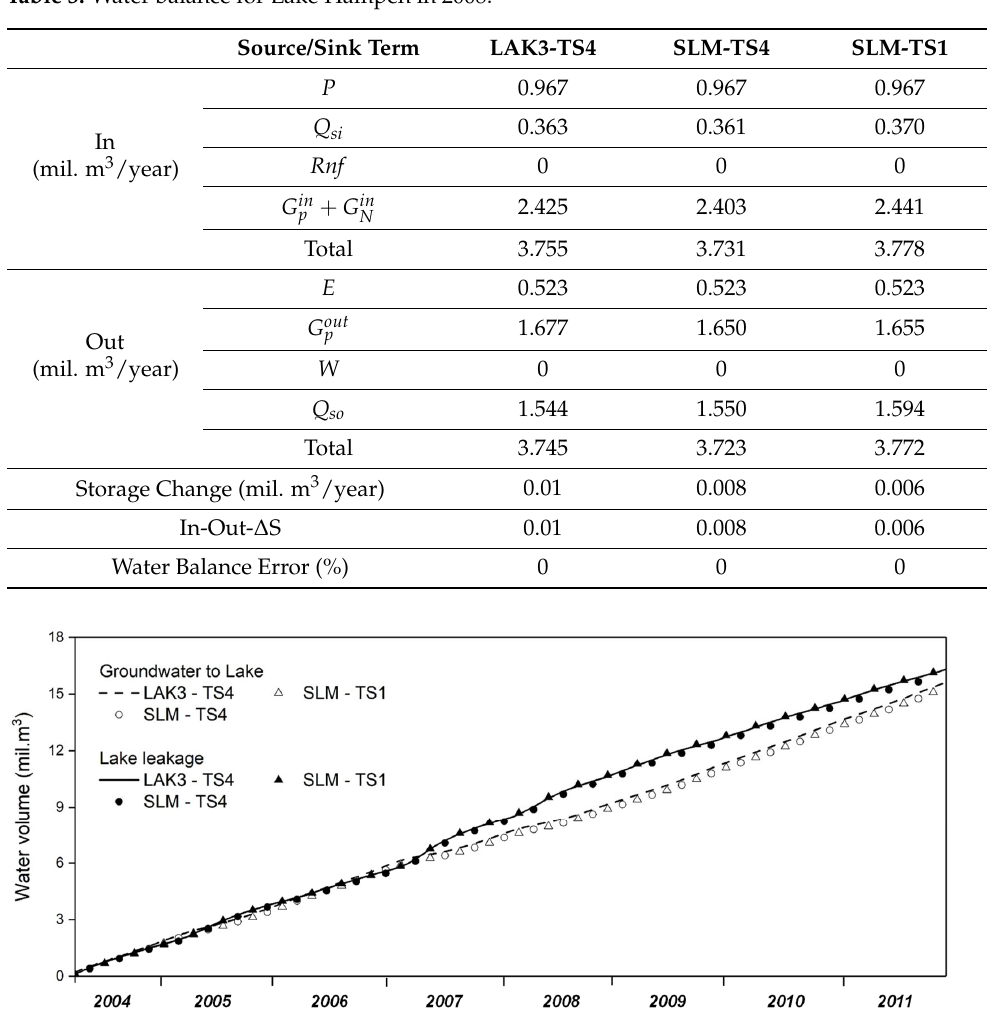
Figure 9. Cumulative Lake–Groundwater interaction water volume since the initial